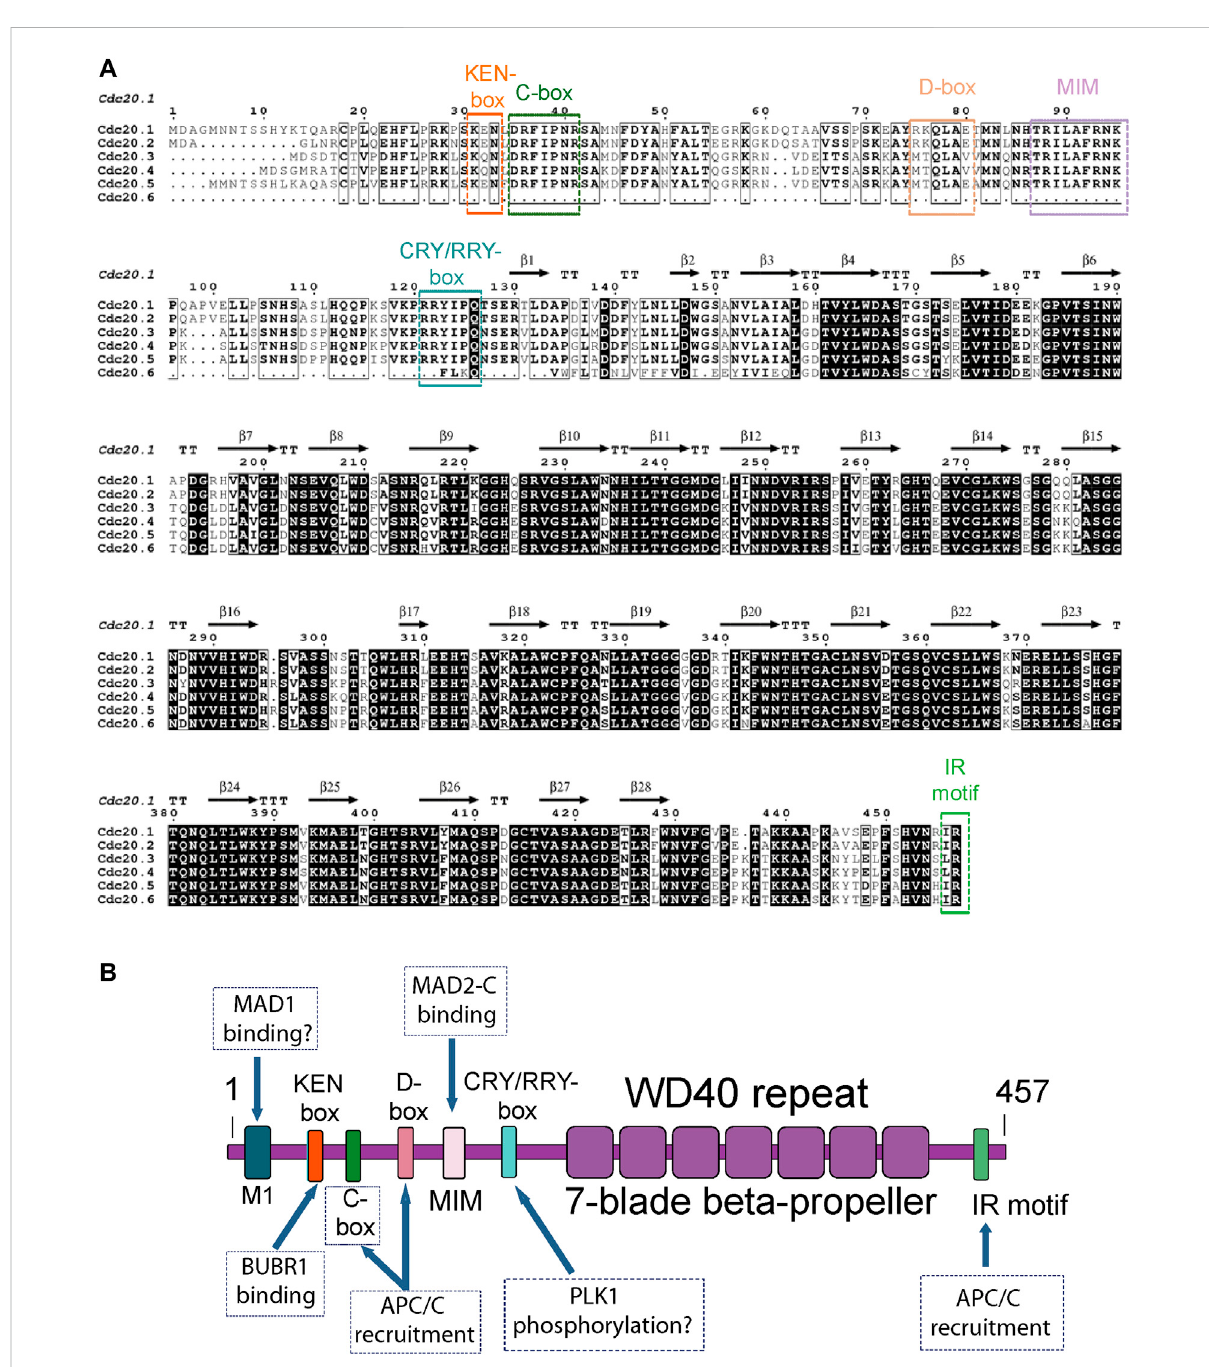
FIGURE 1 (A) Amino acid sequence alignment of the six AtCDC20 isoforms reported to date. The assignation of secondary structure elements was based on the 3D model structure of the AtCDC20.1 WD40 domain. The alignment was created with Clustal Omega (Sievers et al., 2011) and visualised with EsPript (Robertand Gouet, 2014). (B) Domain organisation and distribution ofSLiMs of full length AtCDC20. The boxes indicate theknown functions of the CDC20 SLiMs in the SAC. MIM refers to the MAD2-interacting motif. Plausible functions of other potential motifs of AtCDC20 are indicated with a question